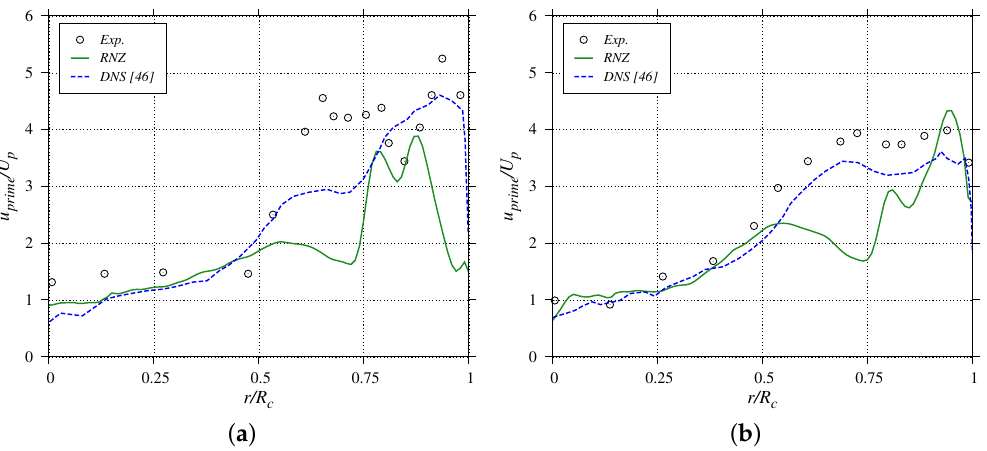
Figure 12. Radial distribution of the RMS axial velocity fluctuation u prime at θ = 90 ◦ : ( a ) z = − 20 mm; ( b ) z = − 30